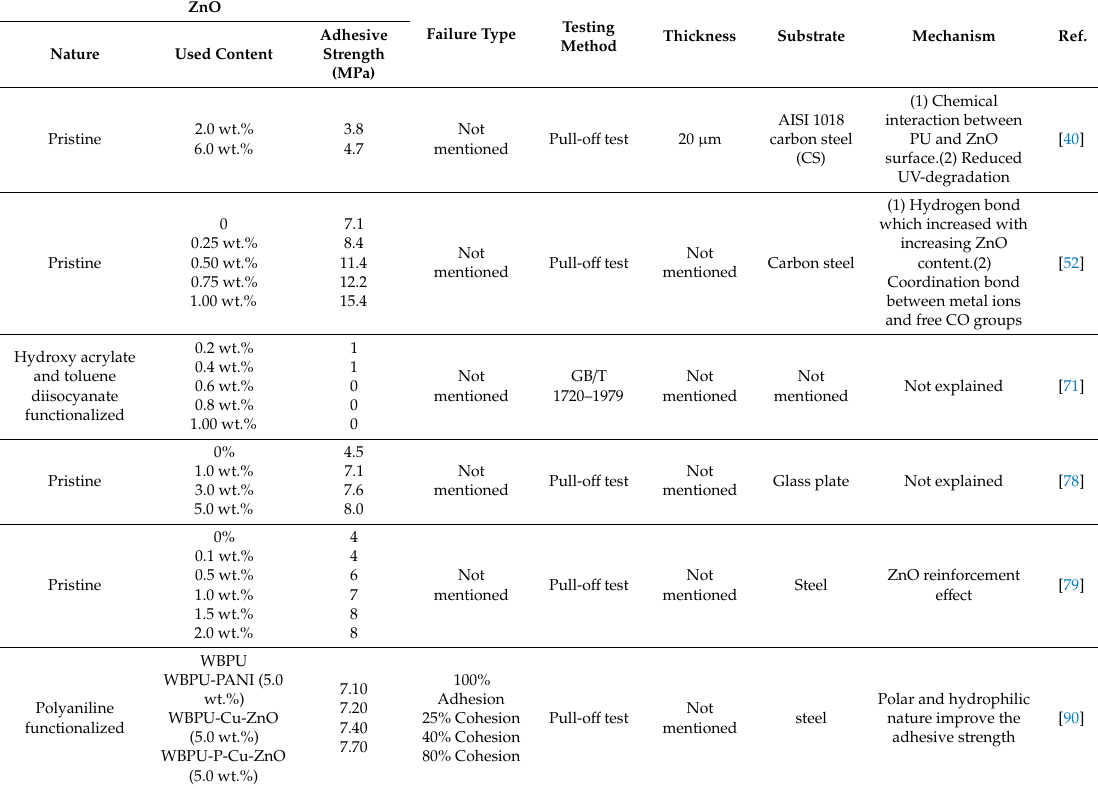
Table 5. Adhesion of PU / ZnO composite